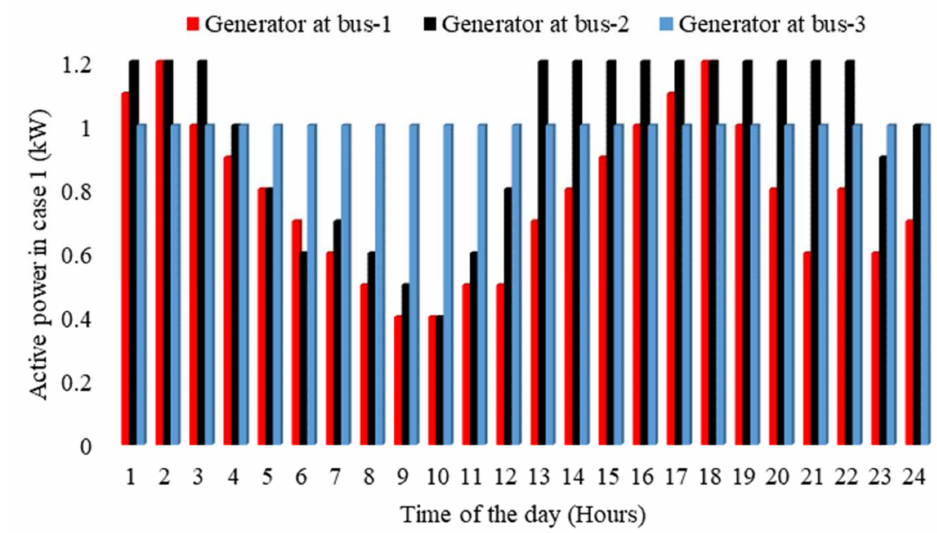
Figure 4. Generator commitments at Buses 1, 2, and 3 (base case problem).